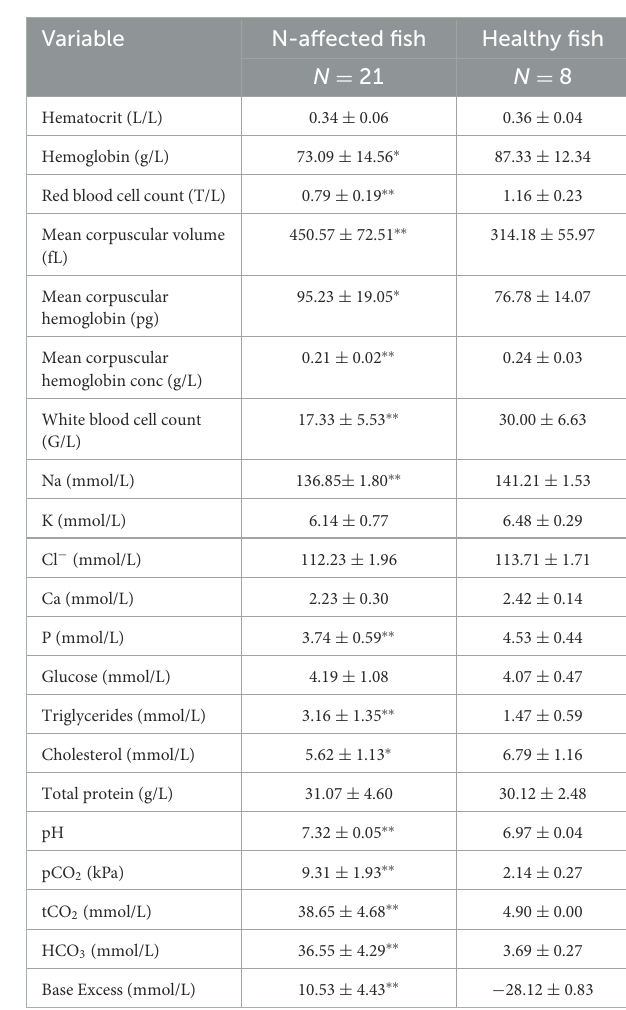
TABLE 2 Hematology and blood chemistry values measured in nephrocalcinosis (N)-affected and healthy rainbow